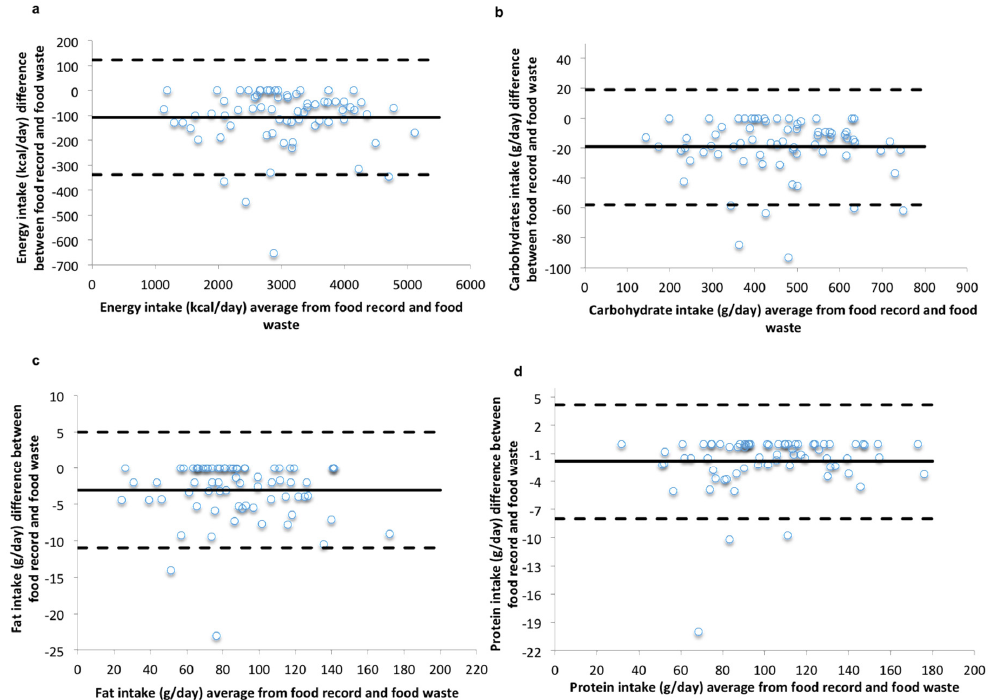
Figure 2. Repeated Measures Bland ‐ Altman plots of the difference between intakes recorded by the wFR and those obtained from the measured food intake/waste method against the mean values for the two methods for ( a ) energy; ( b ) carbohydrates; ( c ) fat; and ( d ) protein. The solid line indicates the mean difference (energy − 108 kcal/day, carbohydrates − 19 g/day, fat − 3.1 g/day and protein − 1.8 g/day) and the dashed line indicates 95% LOA (1.96 SD) for nutrient intakes (energy − 338 kcal/day, 122 kcal; carbohydrates − 58 g/day, 19 g/day; fat − 11 g/day, 5 g/day, and protein − 8 g/day, 4.2